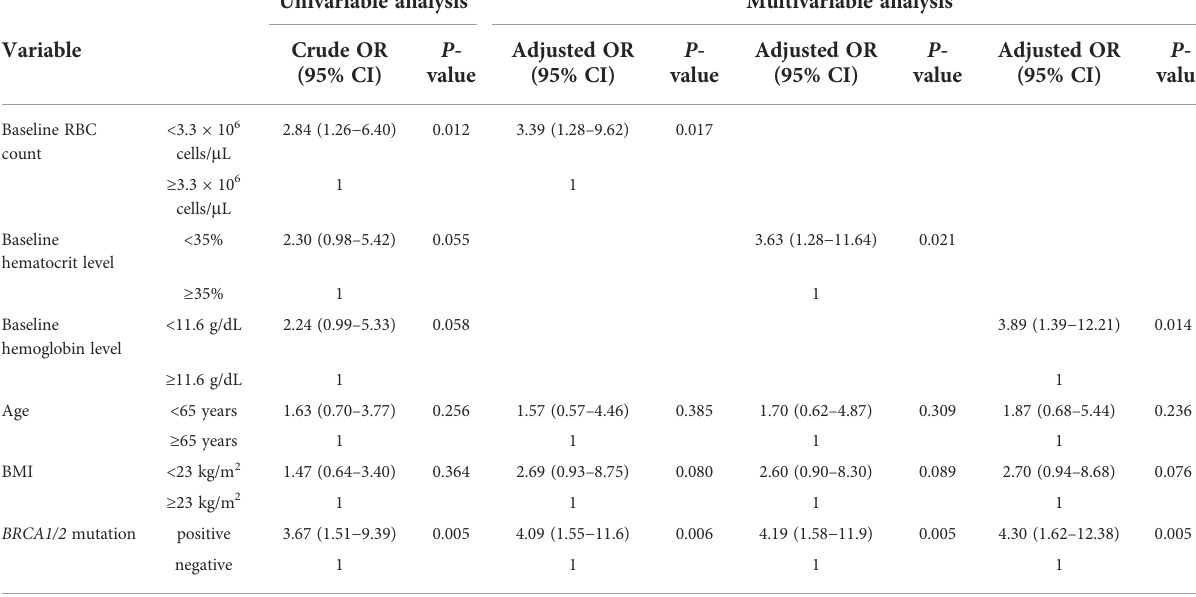
TABLE 2 Patient-speci fi c risk factors associated with the onset of grade ≥ 3 anemia. Univariable analysis